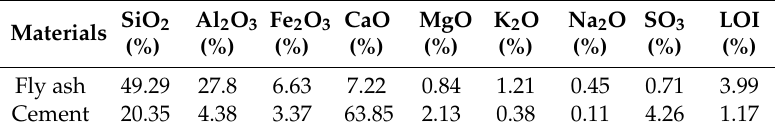
Table 3. Chemical compositions of cement and fly ash (major constituents).